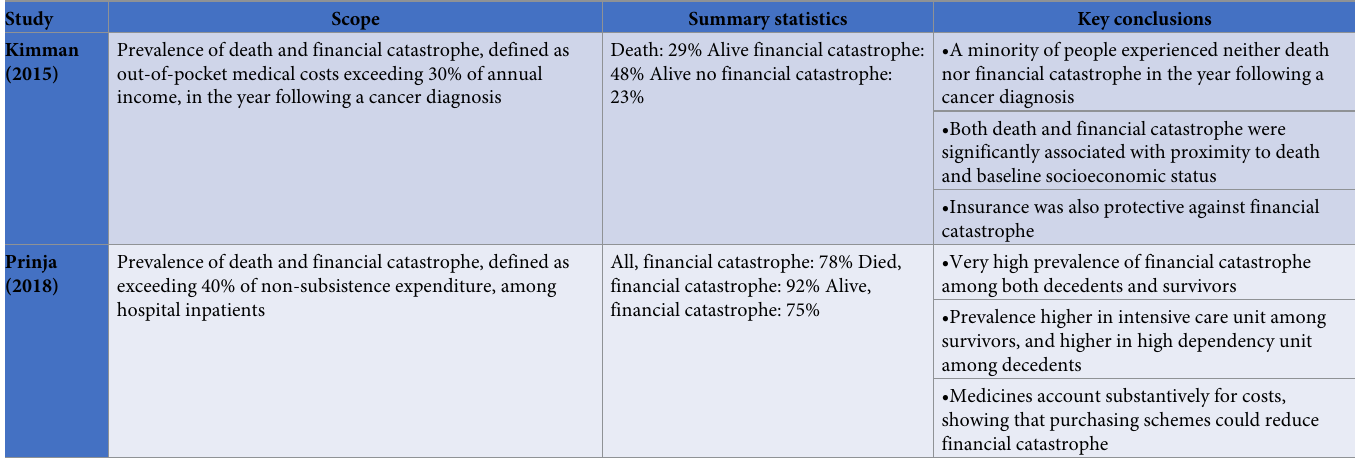
Table 3. Results of studies quantifying catastrophic financial circumstances.